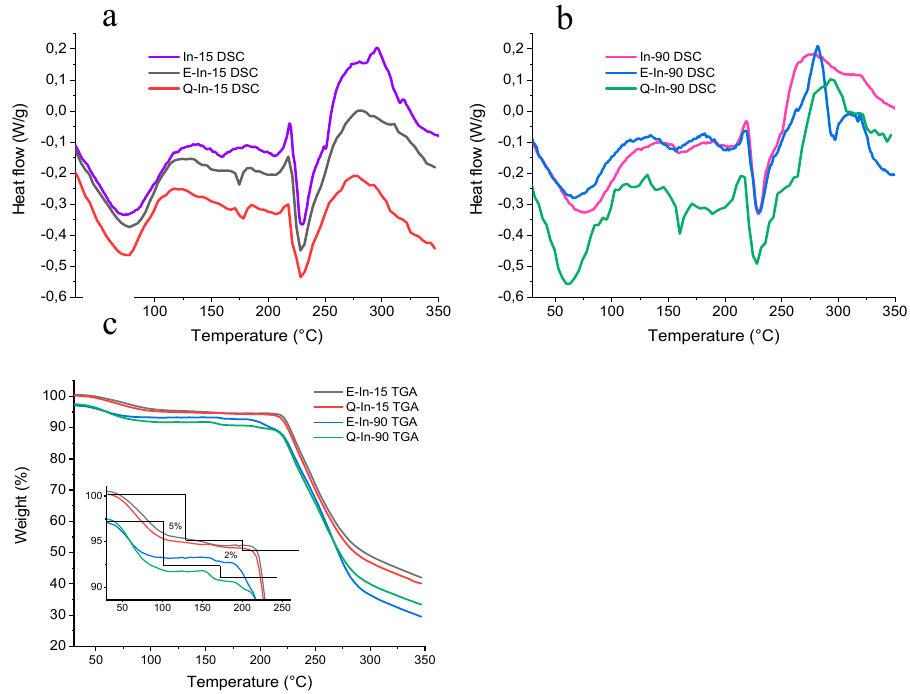
Figure 2. DSC ( a and b ) and TGA ( c ) curves for empty microparticles (In-15 and In-90) and flavonoid-inulin microparticles (E-In-15, E-In-90, Q-In-15, and Q-In-90).